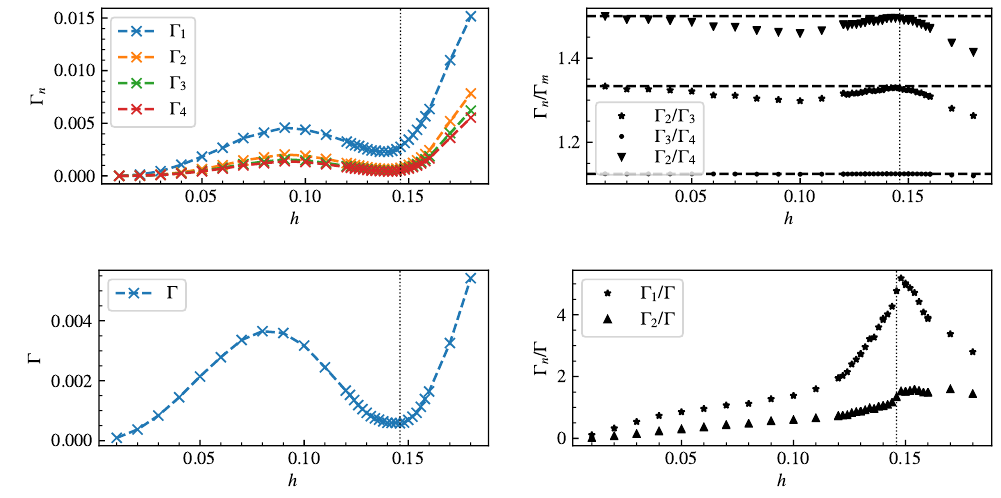
Figure B.2: Left panels: Entropy growth rates Γ (top) and magnetisation relaxation n rate Γ (bottom) for longitudinal quenches in the quantum Ising spin chain starting from g = 1.5 as a function of the longitudinal coupling, in units with J = 1. Right: / Γ / Γ (bottom). The dashed lines represent the universal ratios Ratios Γ (top) and Γ n m n (3.10) that are restored in the limit h → 0. The vertical line is drawn at the value h where the second quasi-particle appears in the post-quench crit